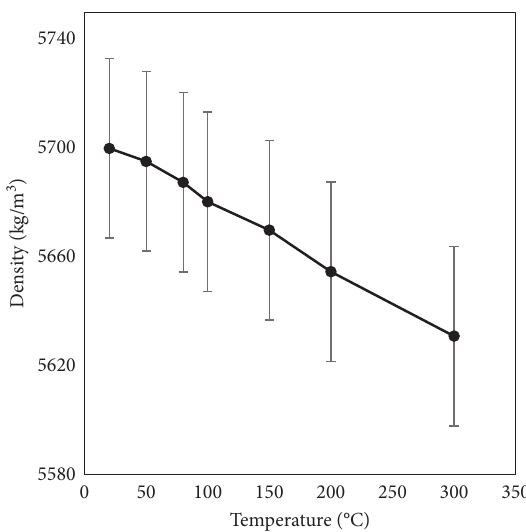
Figure 4: Density of CuCD RHP3434.